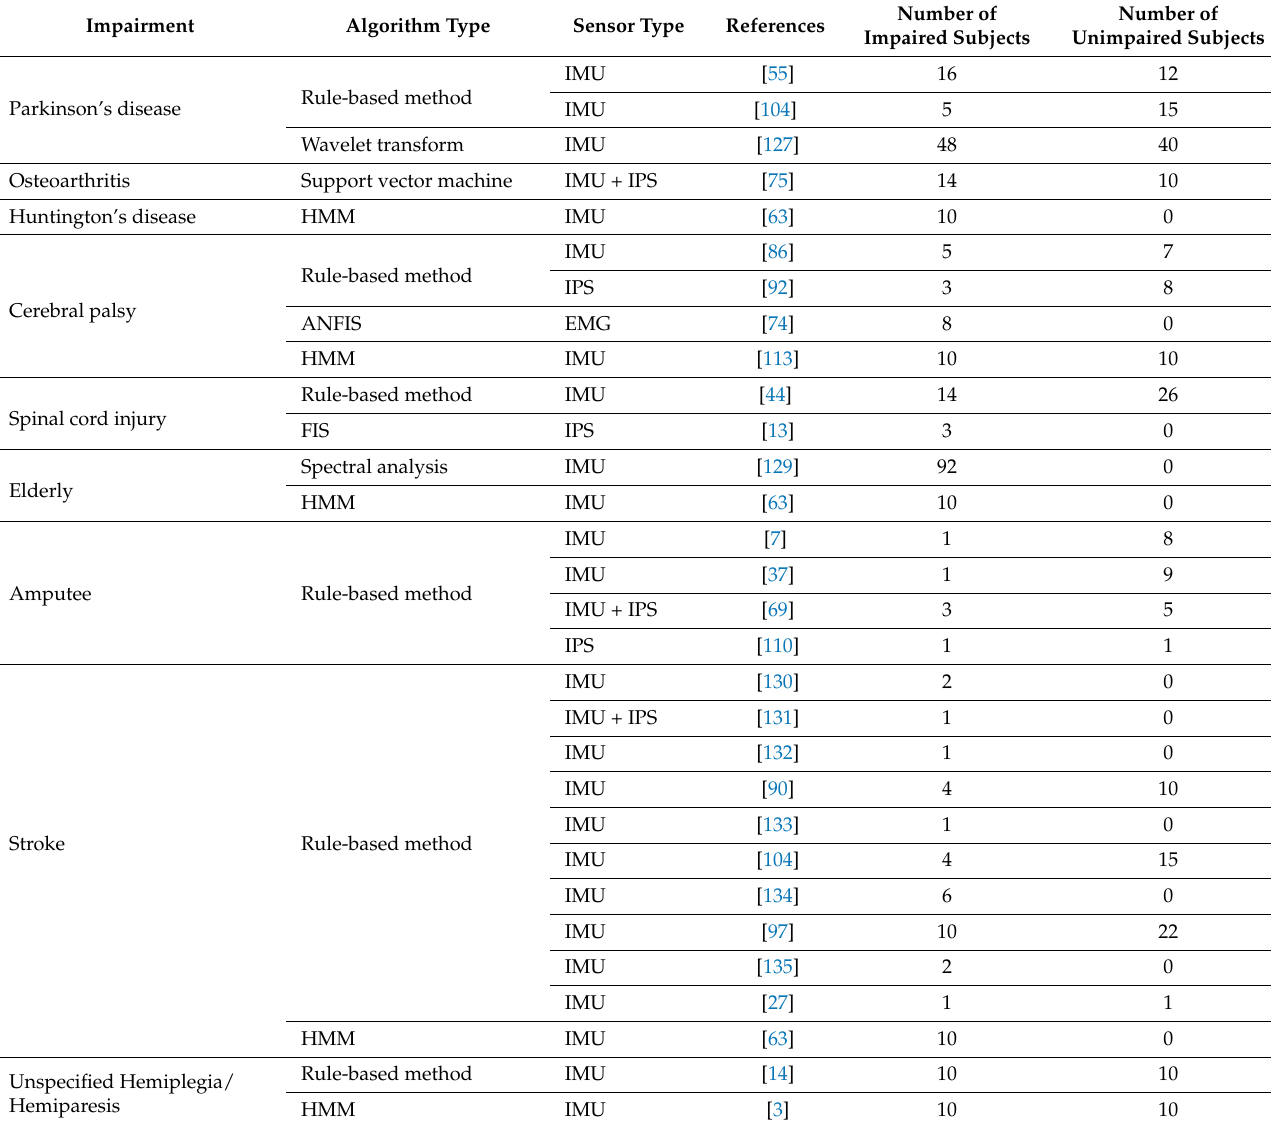
Table 6. Algorithm types categorized with respect to the impairment of subjects on which they were validated. Impairments are categorized based on how they were characterized in the respective study. The number of impaired and unimpaired subjects involved in the study suggest the reliability and popularity of the given algorithmic approach for that specific impairment. Note that some studies (such as [63]) are listed more than once in the table depending on whether they employed more than one category of impaired subjects. FIS—Fuzzy inference system, ANFIS—Adaptive neuro fuzzy inference system, HMM—Hidden Markov